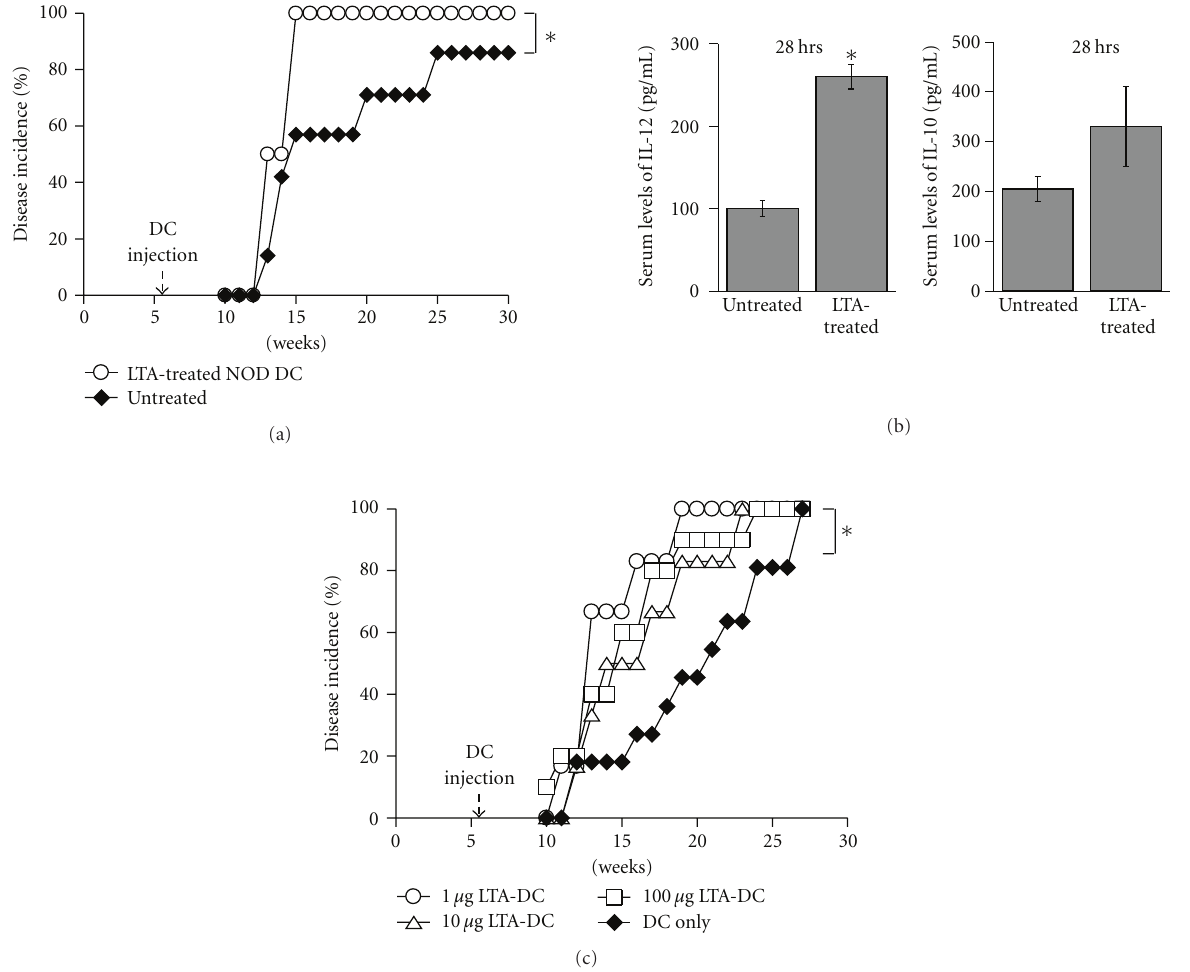
Figure 2: Incidence of diabetes in NOD mice injected with LTA-treated DCs. BM-DCs from NOD mice were stimulated in vitro overnight with 10 μ g/mL of LTA from S. aureus (LTA) or medium alone (none), washed, and one million DCs were injected into six-week-old NOD mice ( n = 5-6), and blood glucose was monitored weekly (a). Sera from pooled NOD mice untreated or injected with DCs treated with LTA were collected at 28 hrs after injection and tested for the presence of IL-12 and IL-10 by ELISA (b). One million DCs untreated or treated with 1, 10 or 100 μ g/mL of LTA were injected into six-week-old NOD mice ( n = 6–11), and blood glucose was monitored weekly (c). Mice were considered diabetic when their blood glucose levels were > 300 dL/mL for 2 consecutive weeks. ∗ indicates a significant di ff erence from the “DC only” or “untreated” group at P < .